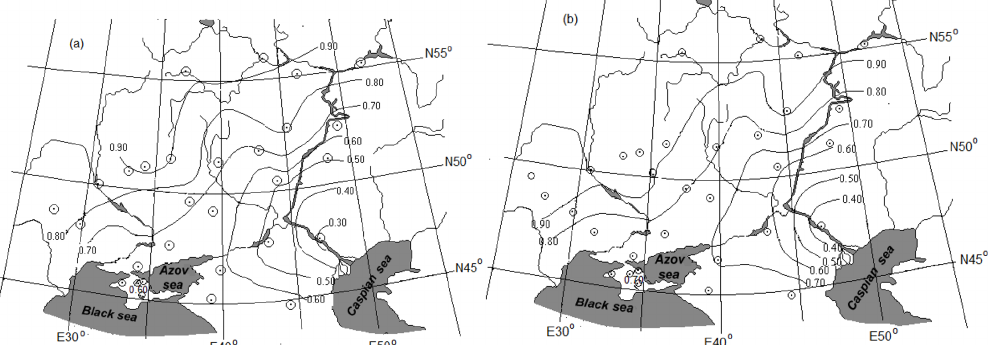
Figure 3. Distribution of many-year averages of the index of plant water supply η w (a) without mulching the agricultural fields and (b) in the case of soil